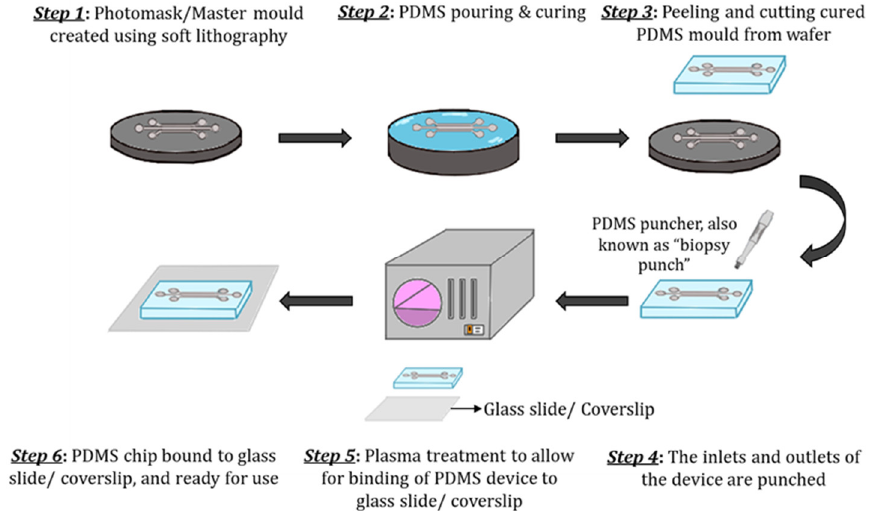
Figure 4. Schematic of the step-by-step process of PDMS device fabrication. ( Step 1 ) The master mould is created using soft lithography. ( Step 2 ) The PDMS mixture (10:1 (base: curing agent)) is poured over the master mould and cured. ( Step 3 ) The solidified PDMS is then cut and peeled from the master mould. ( Step 4 ) The inlets and outlets are punched using a biopsy puncher. ( Step 5 ) The PDMS chip and glass slide/coverslip are activated through plasma treatment. ( Step 6 ) Finally, the PDMS chip is bound to a glass slide/coverslip and cured further for ~2–5 min at 75 °C and is ready to use.